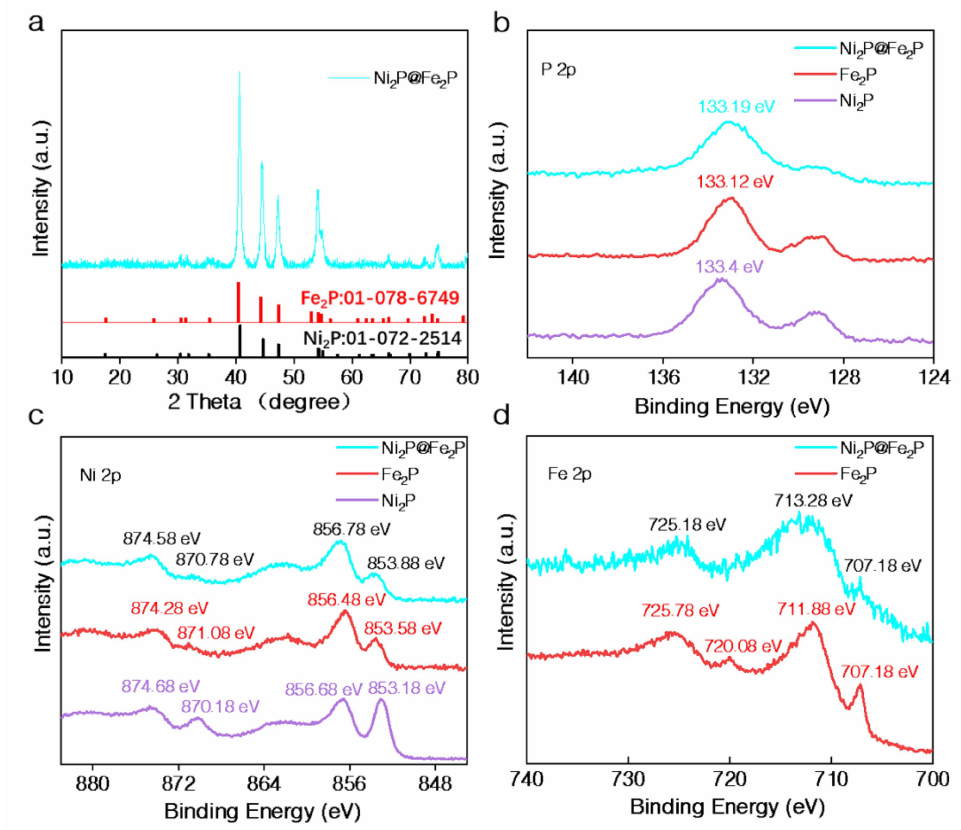
Figure 3. ( a ) XRD pattern of Ni 2 P@Fe 2 P. ( b ) High-resolution P 2p XPS spectra of the Ni 2 P@Fe 2 P, Fe 2 P and Ni 2 P. ( c ) High-resolution Ni 2p XPS spectra of the Ni 2 P@Fe 2 P, Fe 2 P and Ni 2 P. ( d ) High-resolution Fe 2p XPS spectra of the Ni 2 P@Fe 2 P and Fe 2